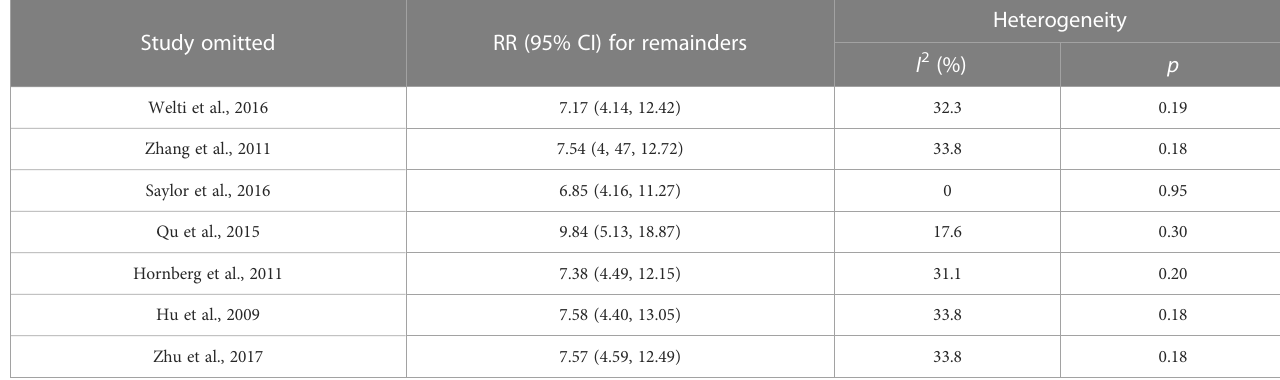
TABLE 2 Sensitivity analysis after each study was excluded by